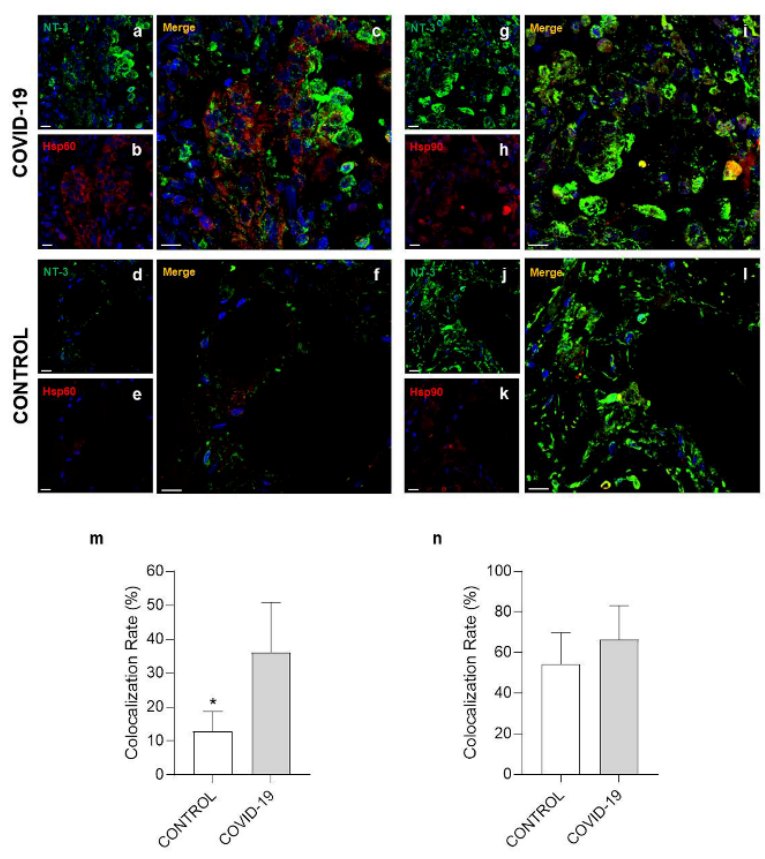
Figure 4. Immunofluorescence for 3-nitrotyrosine, Hsp60 and Hsp90. ( a – c , g – i ) Representative images of COVID-19 lung parenchyma. ( a , b ) Representative immunofluorescence for 3-nitrotyrosine (( a ), green) and Hsp60 (( b ), red); nuclei stained with DAPI are shown in blue. ( c ) The panel shows the merged confocal laser scanning image of 3-nitrotyrosine, Hsp60, and nuclei. ( g , h ) Representative immunofluorescence for 3-nitrotyrosine (( g ), green) and Hsp90 (( h ), red); nuclei stained with DAPI are shown in blue. ( i ) The panel shows the merged confocal laser scanning image of 3-nitrotyrosine, Hsp90, and nuclei. ( d – f , j – l ) Representative images of control lung parenchyma. ( d , e ) Representative immunofluorescence for 3-nitrotyrosine (( d ), green) and Hsp60 (( e ), red); nuclei stained with DAPI are shown in blue. ( f ) The panel shows the merged confocal laser scanning image of 3-nitrotyrosine, Hsp60, and nuclei. ( j , k ) Representative immunofluorescence for 3-nitrotyrosine (( j ), green) and Hsp90 (( k ), red); nuclei stained with DAPI are shown in blue. ( l ) The panel shows the merged confocal laser scanning image of 3-nitrotyrosine, Hsp90, and nuclei. ( m , n ) The bar graph shows the colocalization ratio (%) for 3-nitrotyrosine/Hsp60 ( m ) and 3-nitrotyrosine/Hsp90 ( n ). Open bar, control; shaded bar, COVID-19. Data are presented as the means ± SD. * significantly different from COVID-19 group ( p = 0.0137). Scale bar 25 µ